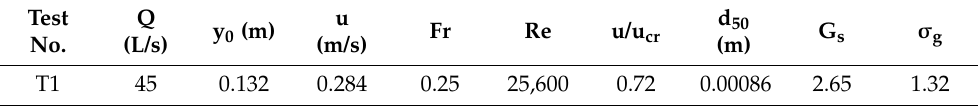
Table 1. Specifications of the parameters for